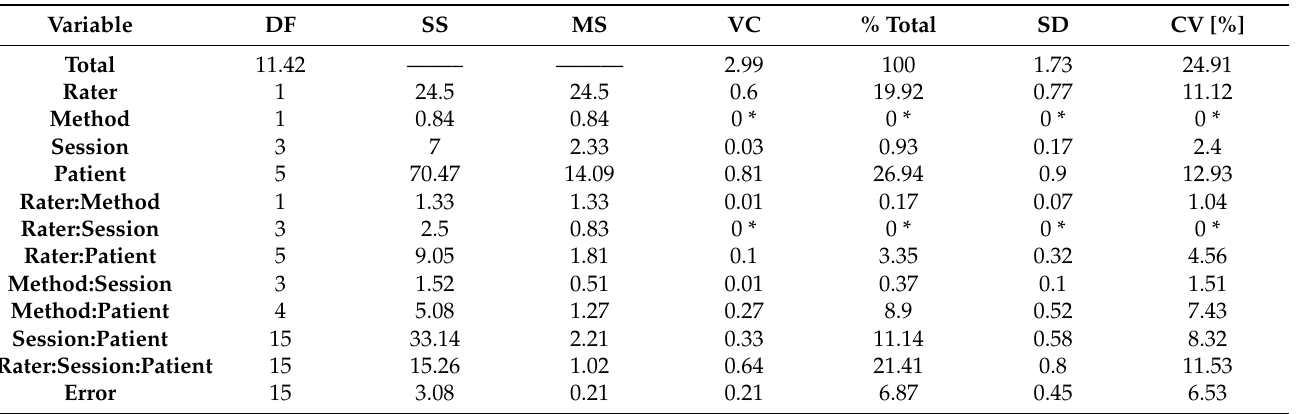
Table 6. Results of MATADOC variance component analysis examining interactions of component variables.